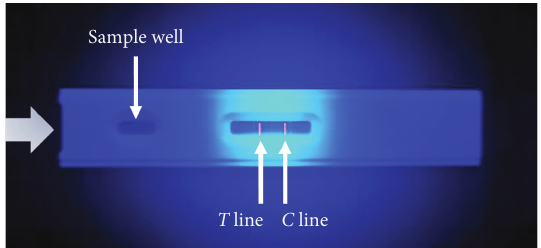
Figure 2: Image of chlorpromazine detection via nanosphere- based time-resolved fluorescence immunoassay under ultraviolet light.